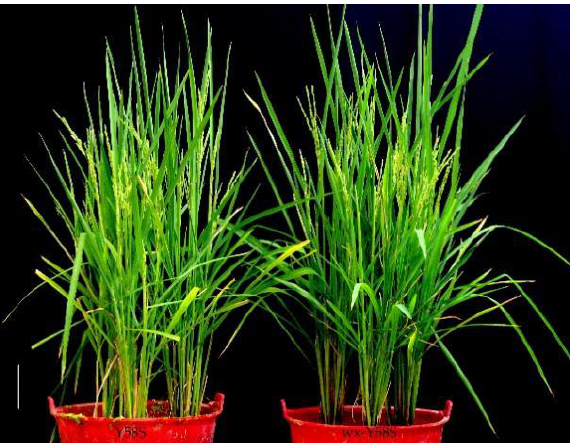
Figure 8. Plant type comparison of wx-Y58S (T 2 W-1-B-5 plants) (left) and the control Y58S plant